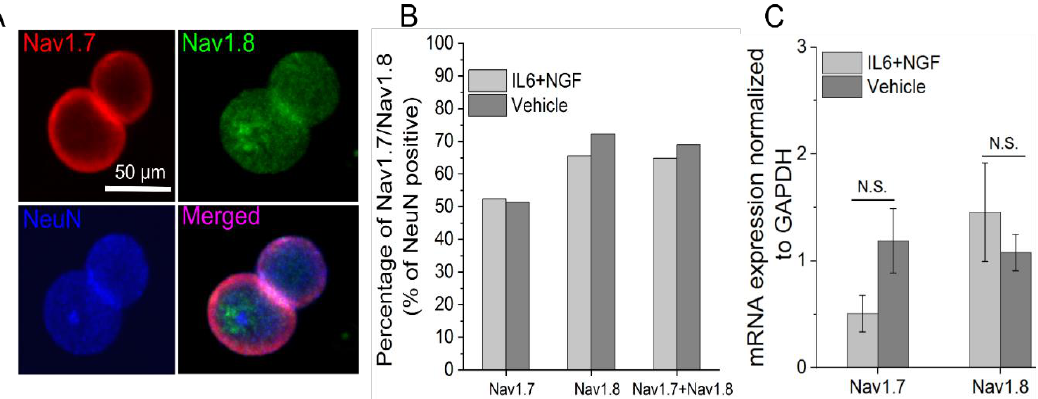
Figure 4. Nav1.7/1.8 expression is maintained in adult DRG neurons in vitro and is unchanged by treatment with IL-6 and NGF. ( A ) Representative immunofluorescence images of adult DRG neurons stained for Nav1.7 (top left; red), Nav1.8 (top right; green), and neuronal marker NeuN (bottom left; blue). ( B ) Percentage of Nav1.7, Nav1.8, and Nav1.7/1.8 co-expressing neurons following exposure to IL-6 and NGF for 72 hours or vehicle. ( C ) mRNA expression of Nav1.7 and Nav1.8 normalized to glyceraldehyde 3-phosphate dehydrogenase (GAPDH) following exposure to IL6 and NGF for 72 hours or vehicle. Errors are expressed as mean ± STD.